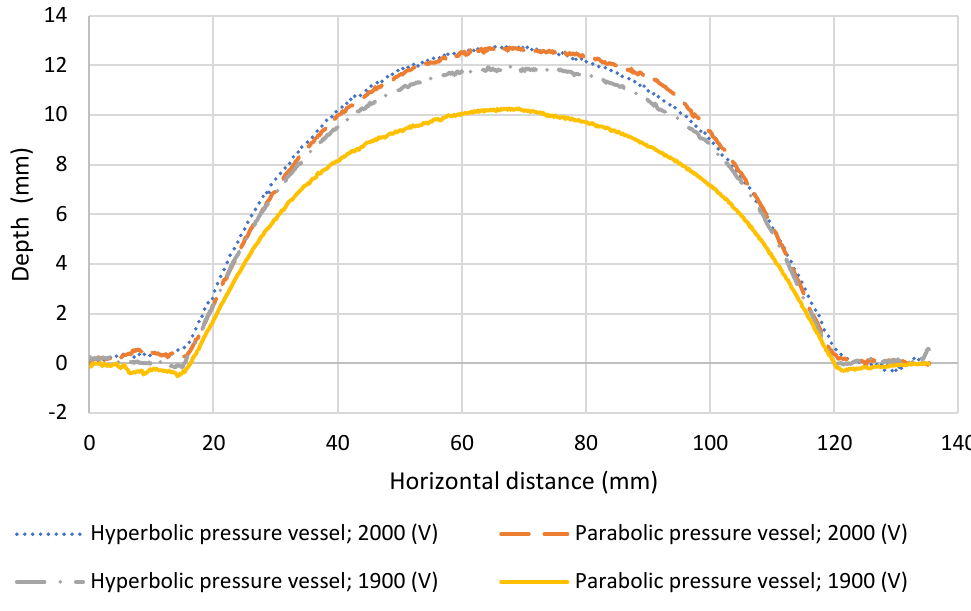
Figure 15. Comparison of pressure vessel shape to charging voltage when an auxiliary plate is overlaid on top of an AZ31 plate.